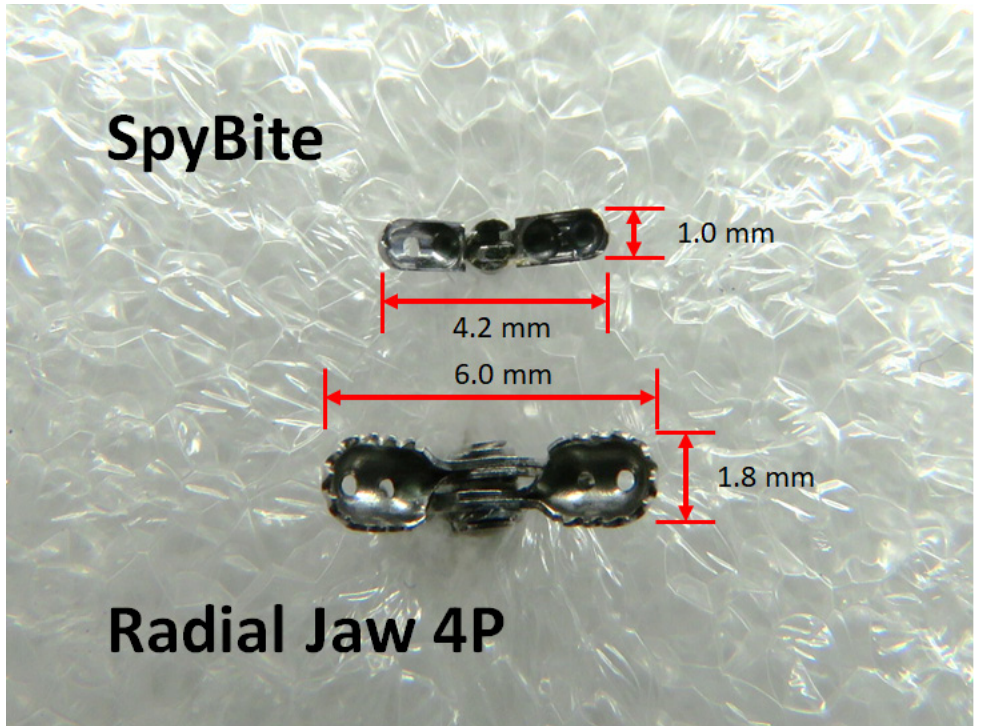
Figure 3. Comparison of biopsy forceps.